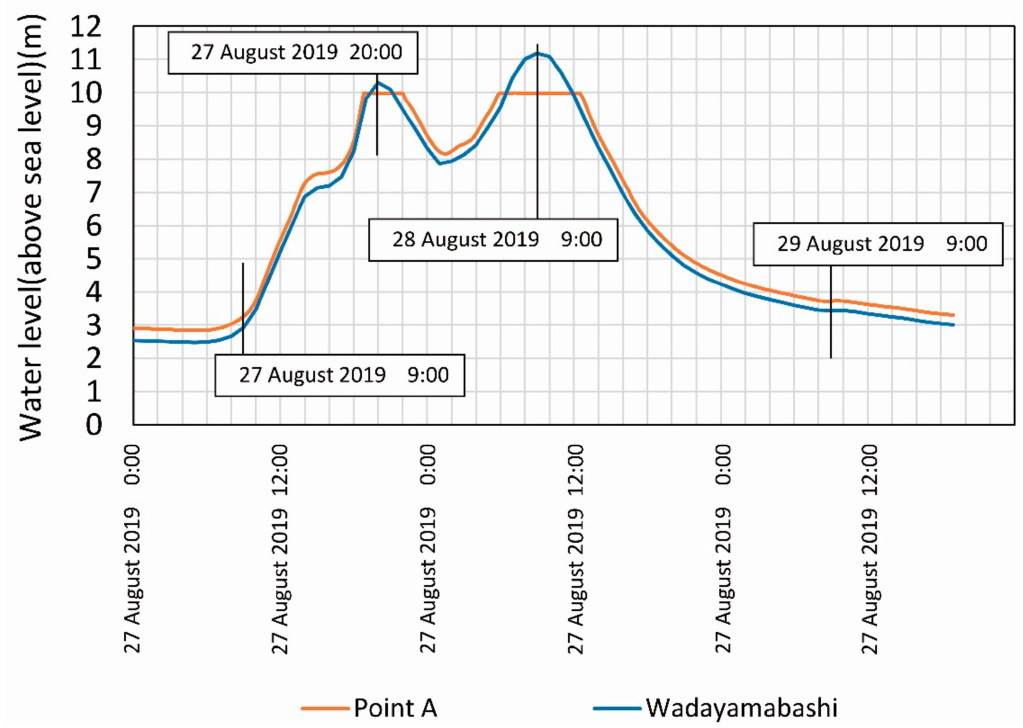
Figure 11. Changes in water level over time at Azame-no-se (Point A) and Wadayamabasi